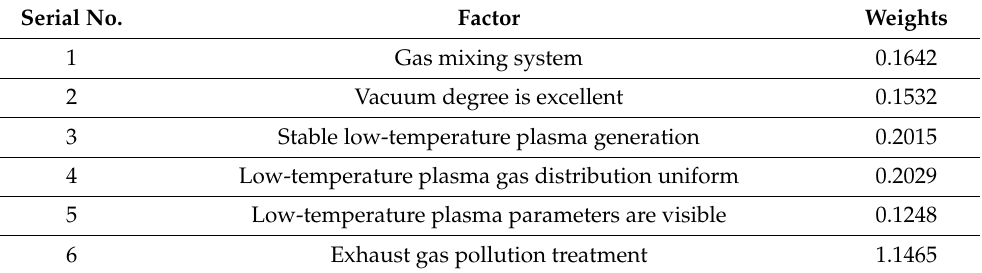
Figure 9. Target, standard and scheme layer of FAHP. Table 1. FAHP weight value of each